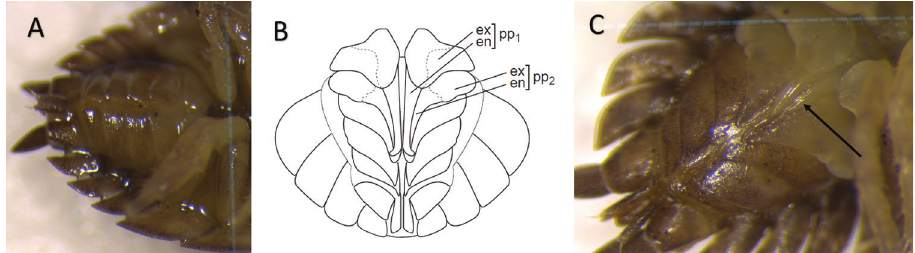
Figure 2. A ventral view of the pleon of a normal female P. scaber B drawing of the ventral view of the male pleon of A. vulgare , similar in morphology to P. scaber C ventral view of the pleon of intersex P. scaber with the endopodite of the first pleopod marked with an arrow. Abbreviations: pp1 first pleopod; pp2 second pleopod; ex exopodite; en endopodite ( B drawn from Shultz